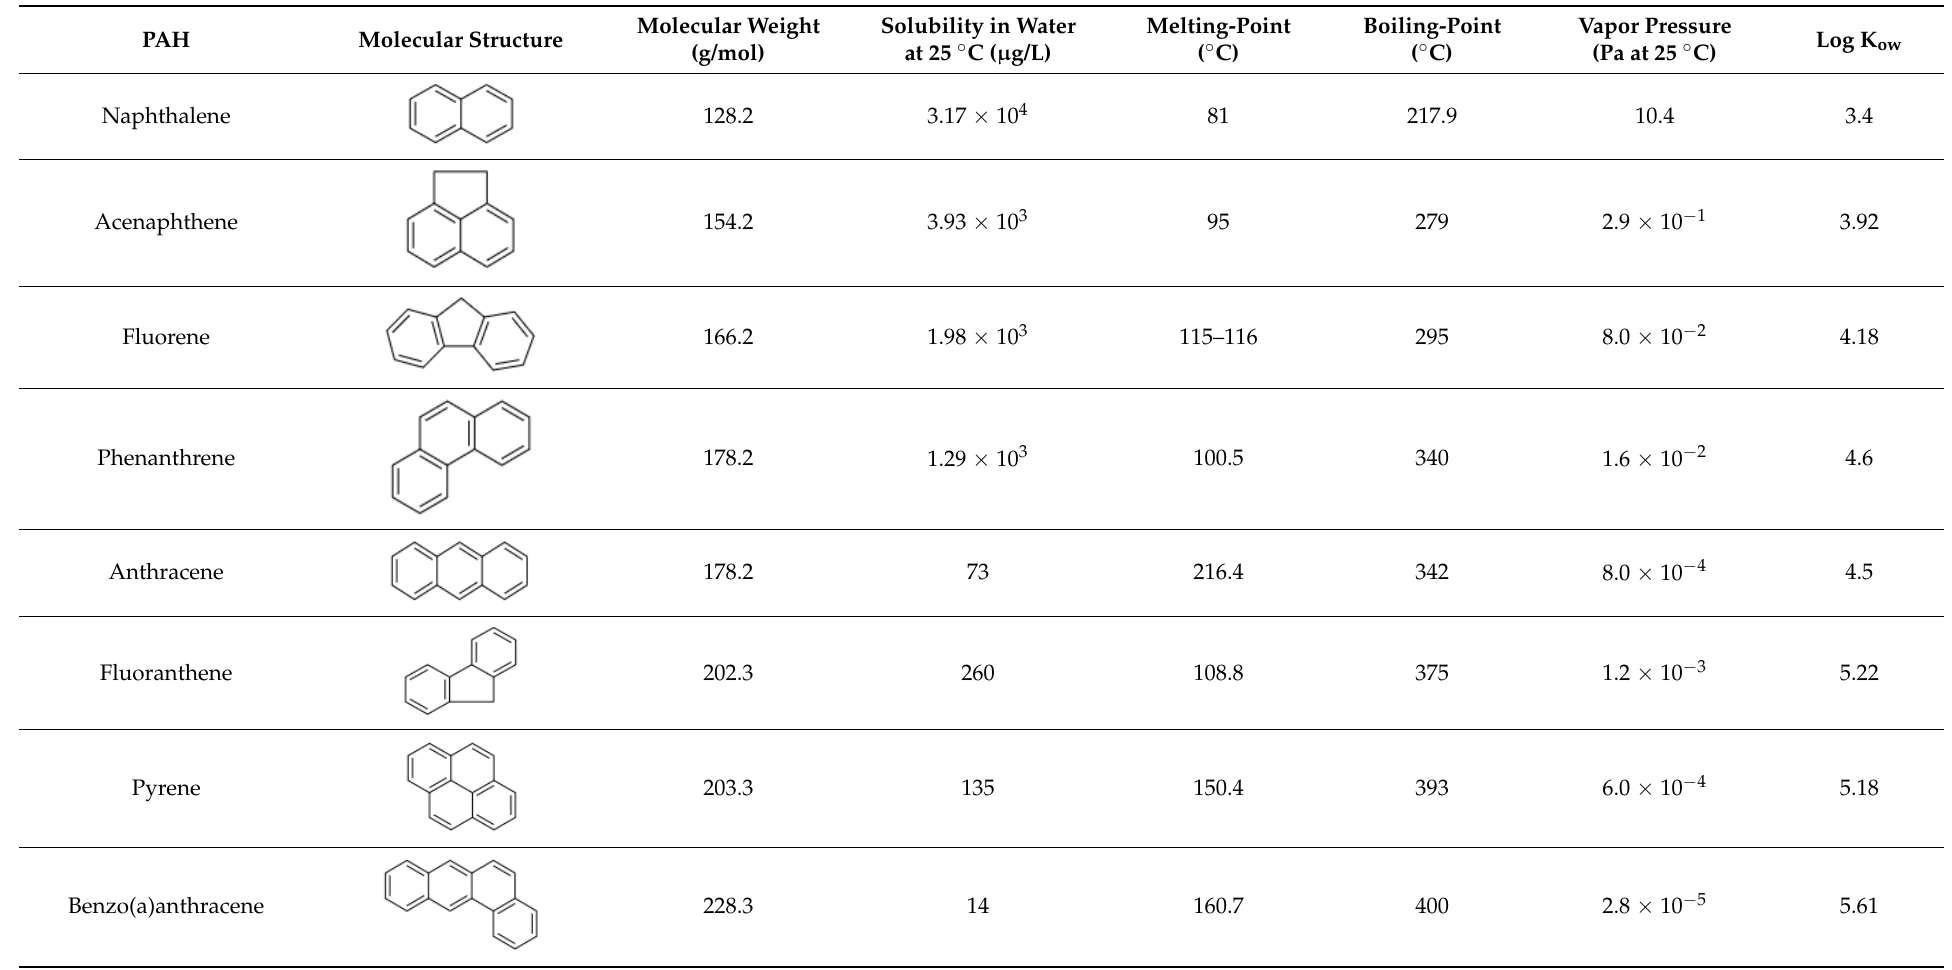
Table 1. Molecular structure and physicochemical properties of the PAHs.